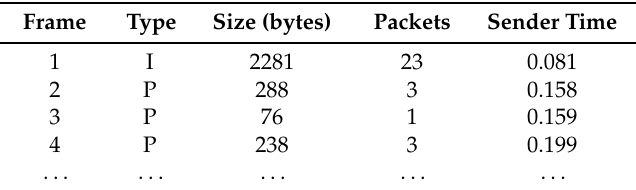
Table 3. Sender trace file